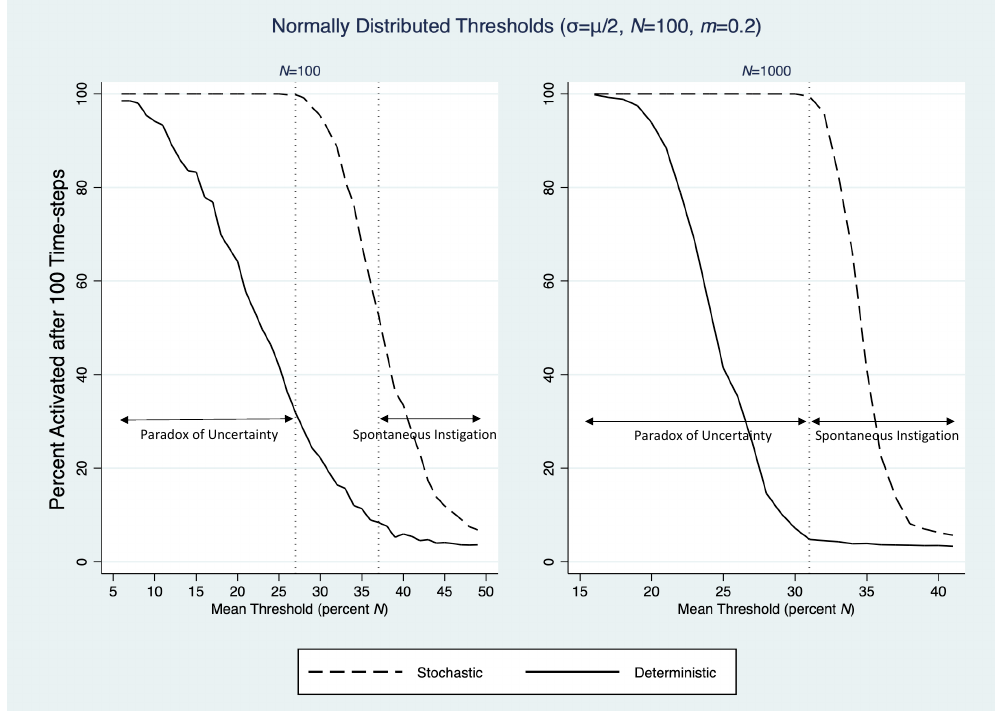
Figure 7: Predicting activation levels from collective interests as N increases from 100 to 1,000. Unpredictability is indicated by the change in percentage activated as the mean threshold increases (expressed as percent of N ), with σ = µ /2. The dotted vertical lines demarcate regions in which outcomes are comparatively insensitive to collective interests, either because thresholds are stochastic (paradox of predictability) or deterministic (spontaneous instigation). In the latter region, relatively weak collective interests create start- up problems regardless of random perturbations in group composition, but random errors in individual behavior ( m = 0.2) can trigger successful cascades that are less sensitive to group composition and more sensitive to group